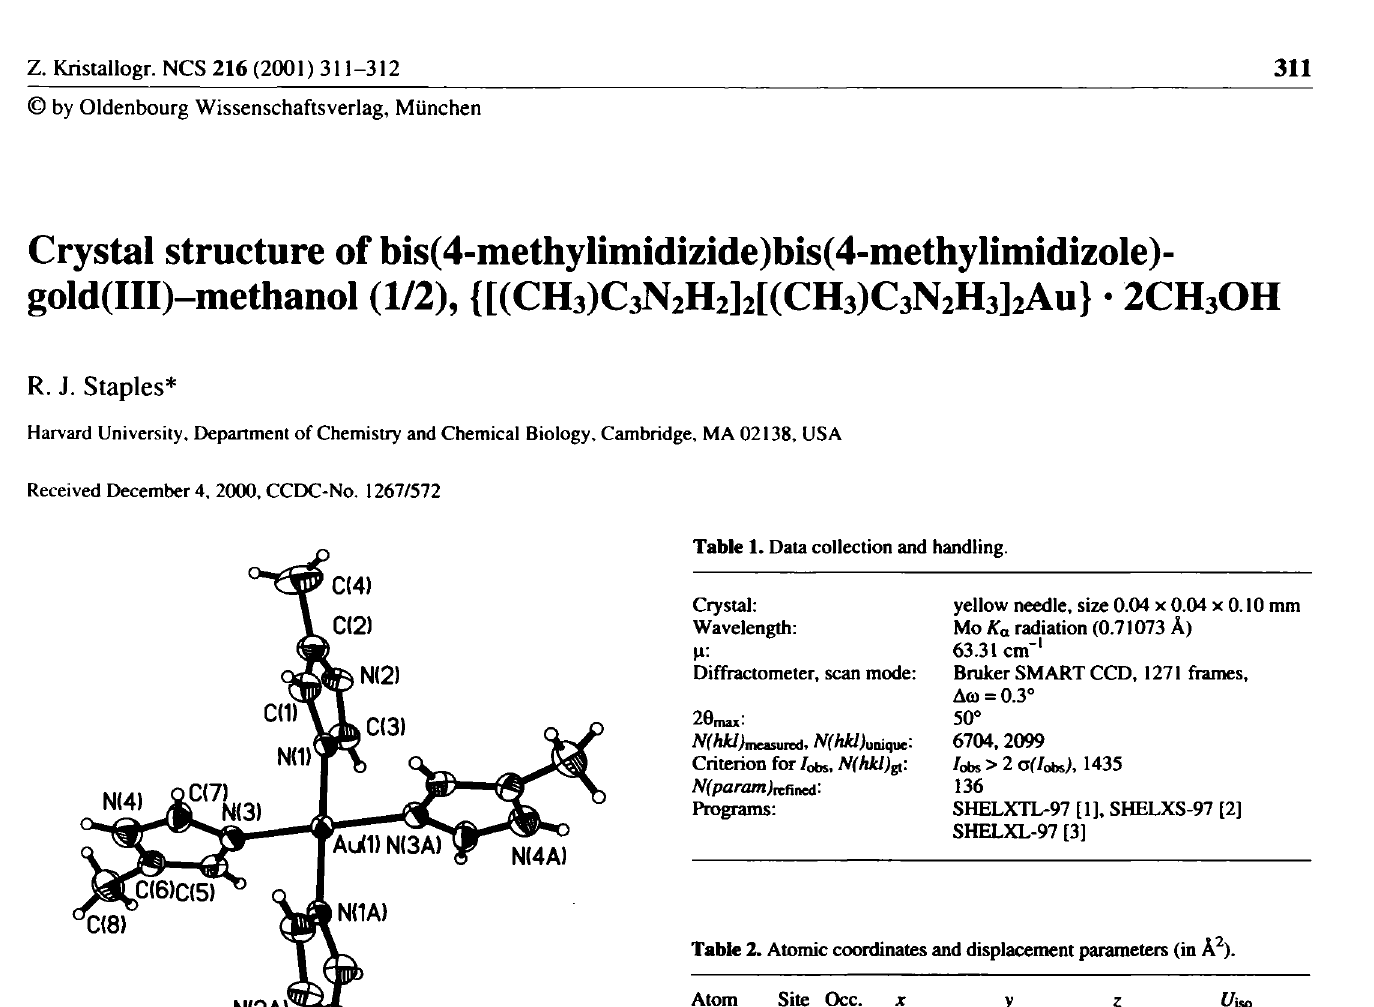
Table 2. Atomic coordinates and displacement parameters (in A 2